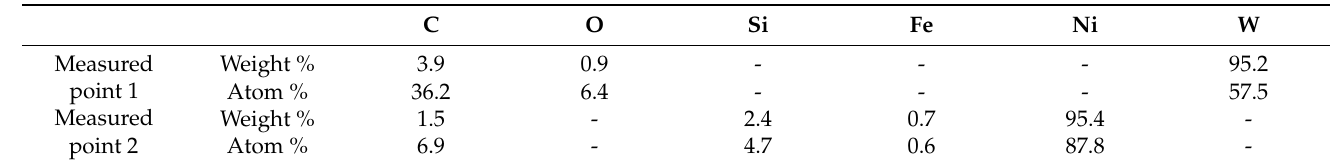
Table 4. Chemical composition in weight % and atom % of measured points of PG powder under analysis.